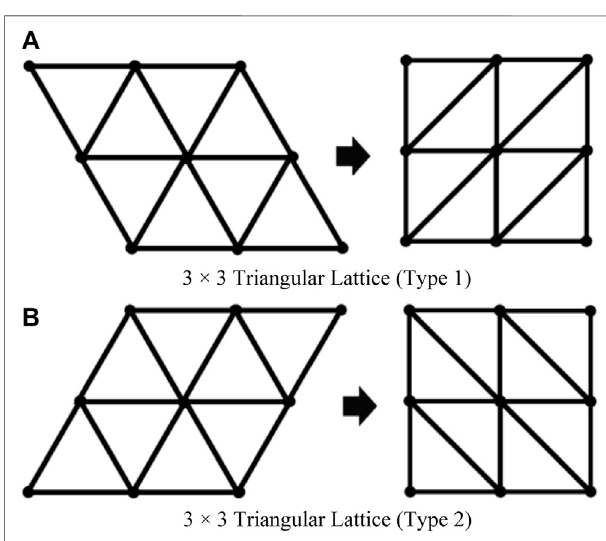
FIGURE5| Triangularlatticegraphs. (A) 3×3Triangularlattice(Type1). (B) 3 × 3 Triangular lattice (Type